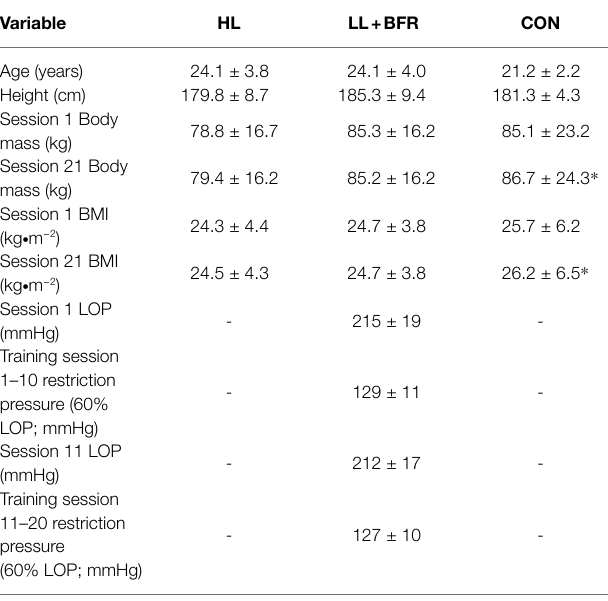
TABLE 1 | Participant anthropometry, and limb occlusion pressure (LOP) in heavy-load resistance training (HL), blood flow restriction training (LL + BFR), and non-training control (CON)